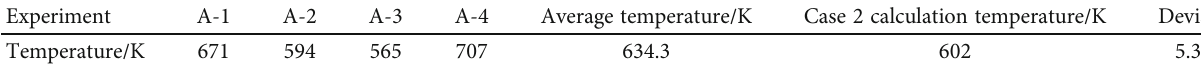
Table 2: Comparison of temperature at point 1 for the simulation and experiments.